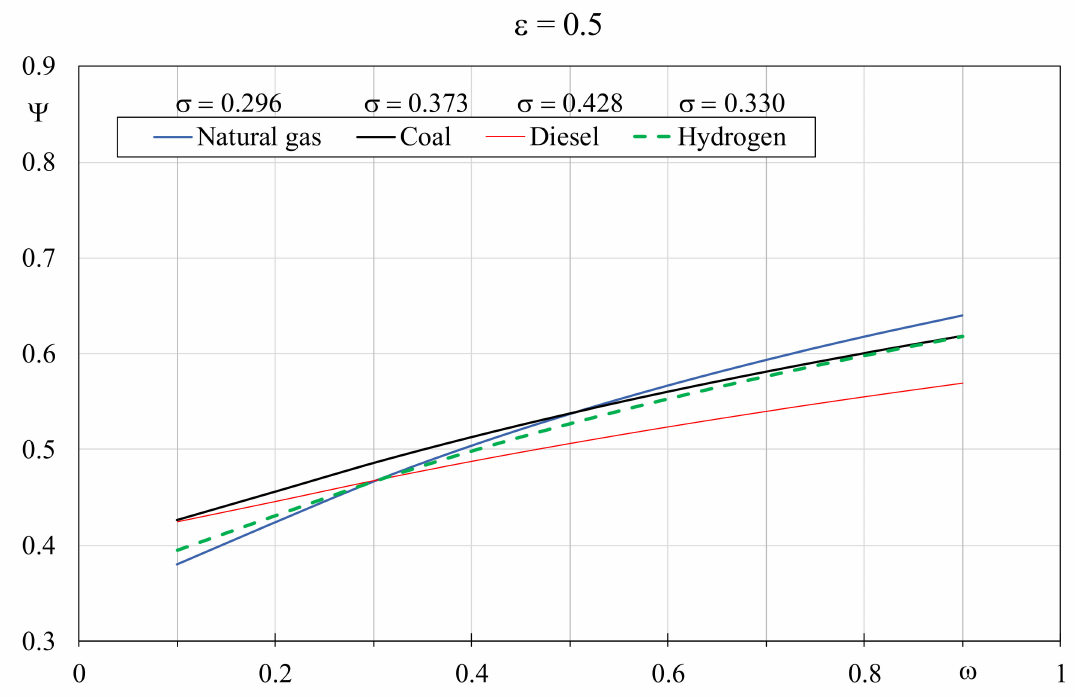
Figure 8. Comparison of the EQI related to the heat exchanger thermal capacity ratio for the considered fuels, with different value of the dimensionless temperature factor and setting ε =